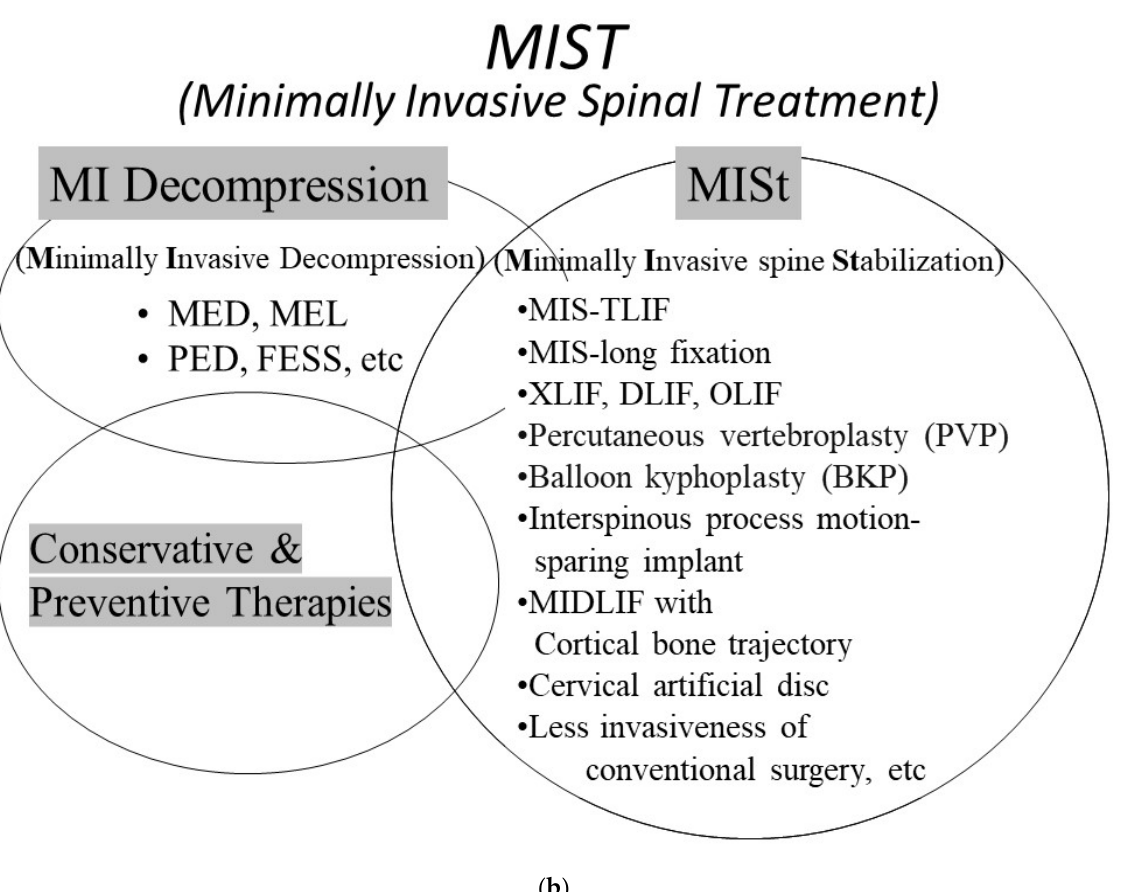
Figure 2. Classifications of minimally invasive therapy. ( a ) Classification of minimally invasive spine surgery (MISS). MISS is classified as two categories (MI decompression and MISt). ( b ) Classification of minimally invasive spinal treatment (MIST). MIST is classified as three categories (MI decompression, MISt, conservative and preventive therapies).